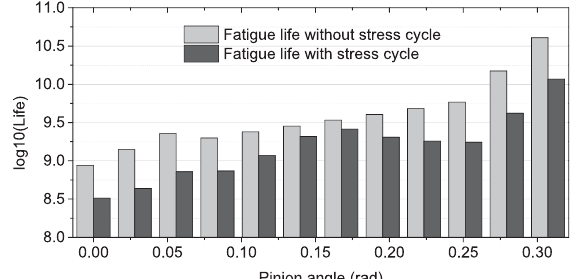
Fig. 13 Fatigue life during the meshing process for the case of no misalignment.